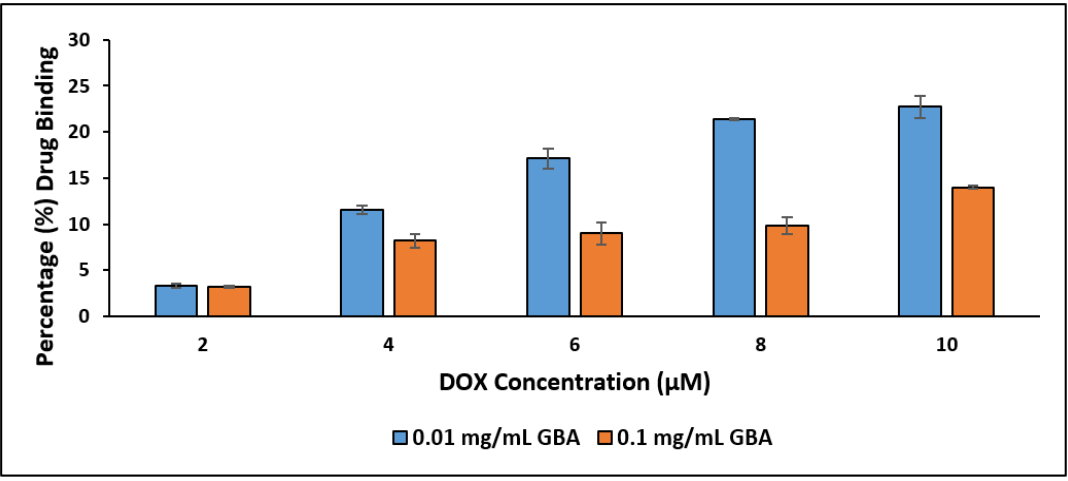
Figure 7. Binding a ffi nity of 0.01 mg / mL and 0.1 mg / mL GBA with di ff erent concentrations (2, 4, 6, 8, Figure 7. Binding affinity of 0.01 mg/mL and 0.1 mg/mL GBA with different concentrations (2, 4, 6, 8, and 10 µ M) of and 10 µM) of DOX.